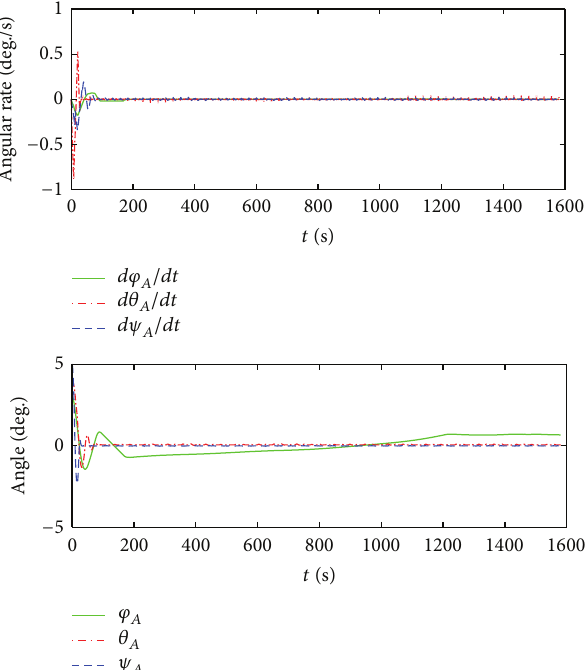
Figure 14: The angular rate and angle of the ROGER spacecraft.